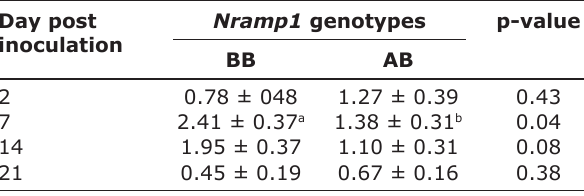
Figure-2: Polymerase chain reaction and restriction fragment length polymorphism digestion of intron 6 of the Nramp1 gene in pig. The lane M is Marker 100 bp ladder; the lane 2-3 are BB genotype, and 4–5 are AB Table-2: Association of SNP in intron 6 of the Nramp1 gene with Salmonella fecal shedding ([×10 4 ] CFU/mL [least square mean ± standard errors]).